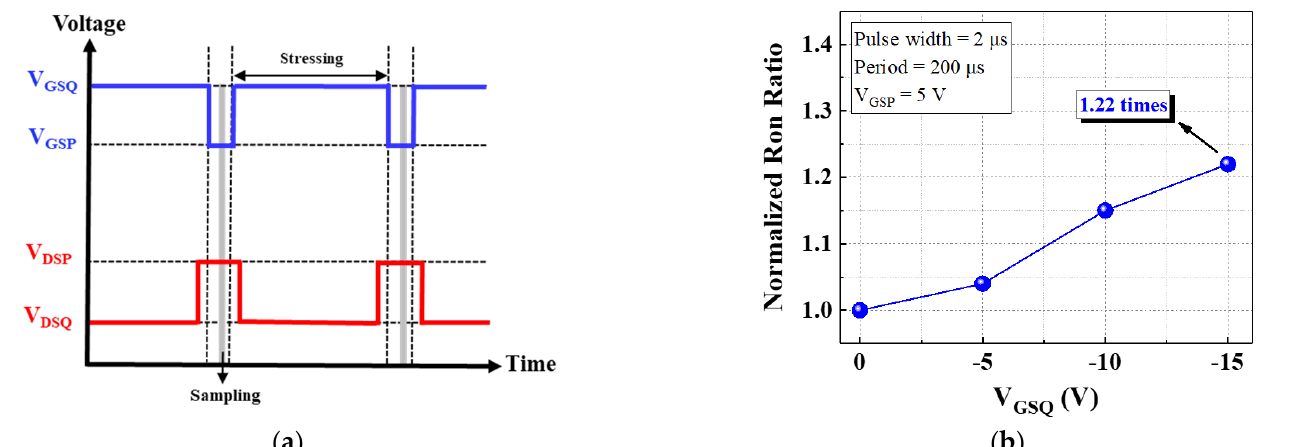
Figure 4. ( a ) Condition of pulse measurement and ( b ) gate lag characteristic. As indicated in Figure 5a, V TH shifted in the positive direction under V GSQ = 6 V